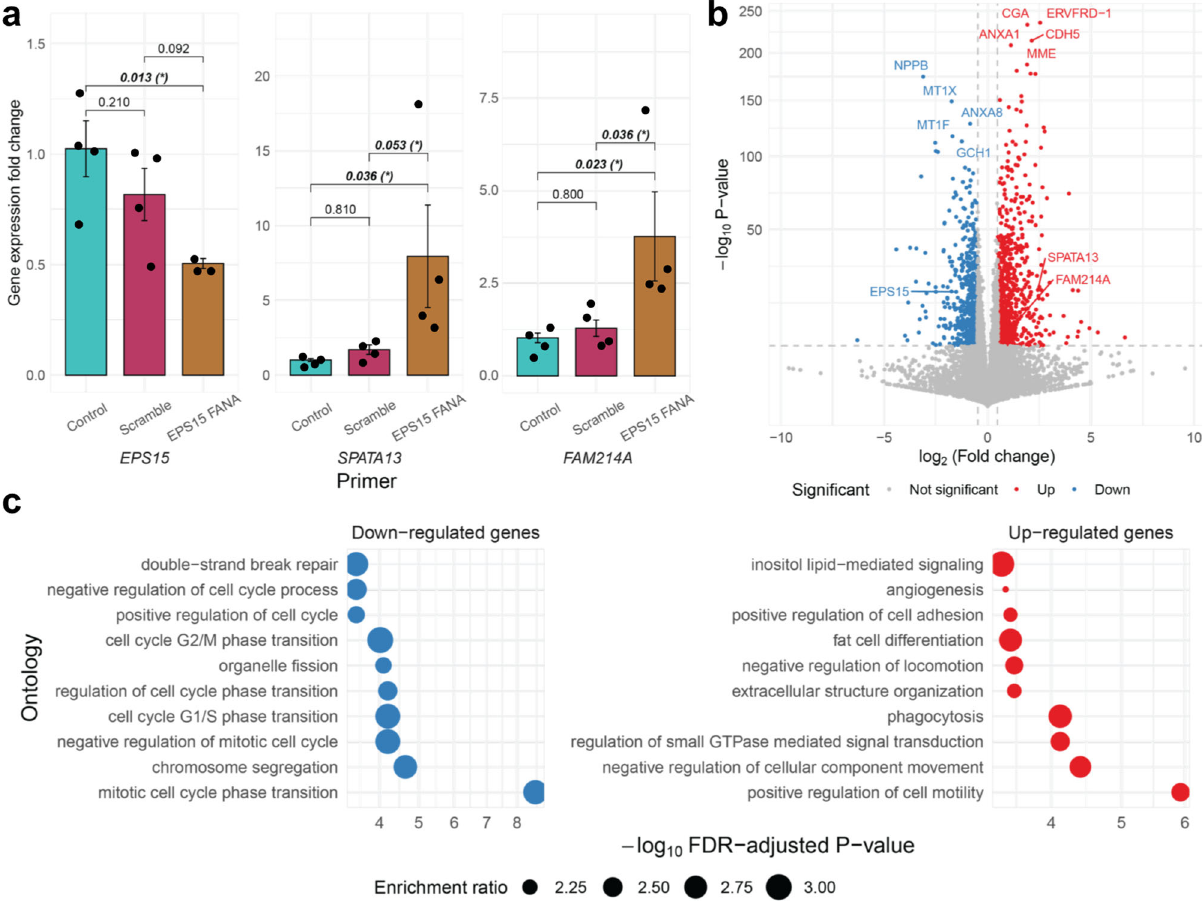
Fig. 6 In vitro experiments in EPS15-knockdown human placenta-derived choriocarcinoma epithelial cells. a Bar graph of the mean gene expression fold- changes with error bars of 1 standard deviation from the qRT-PCR from JEG-3 RNA. Nominal P -values of pairwise t -tests are shown, with an asterisk if Benjamini – Hochberg FDR- adjusted P < 0 : 10 ( n = 2 cells examined over two independent experiments). Note differences in y -axis scales. b Volcano plot of log 2 fold-change ( x -axis) of differential expression across EP15 knockdown cells and scramble oligonucleotide against – log 10 FDR-adjusted P -value ( y -axis; two-sided Wald-type tests from negative binominal regression). Upregulated genes are in red and downregulated genes in blue. Top up- and downregulated genes by P -value are labeled, as well as EPS15 , SPATA13 , and FAM214A . c Enrichment plot of over-representation of down- (blue) and upregulated (red) genes of PANTHER and KEGG pathways ( y -axis) with – log 10 FDR-adjusted P -value ( x -axis; one-sided Fisher ’ s exact test). The size of the point gives the enrichment